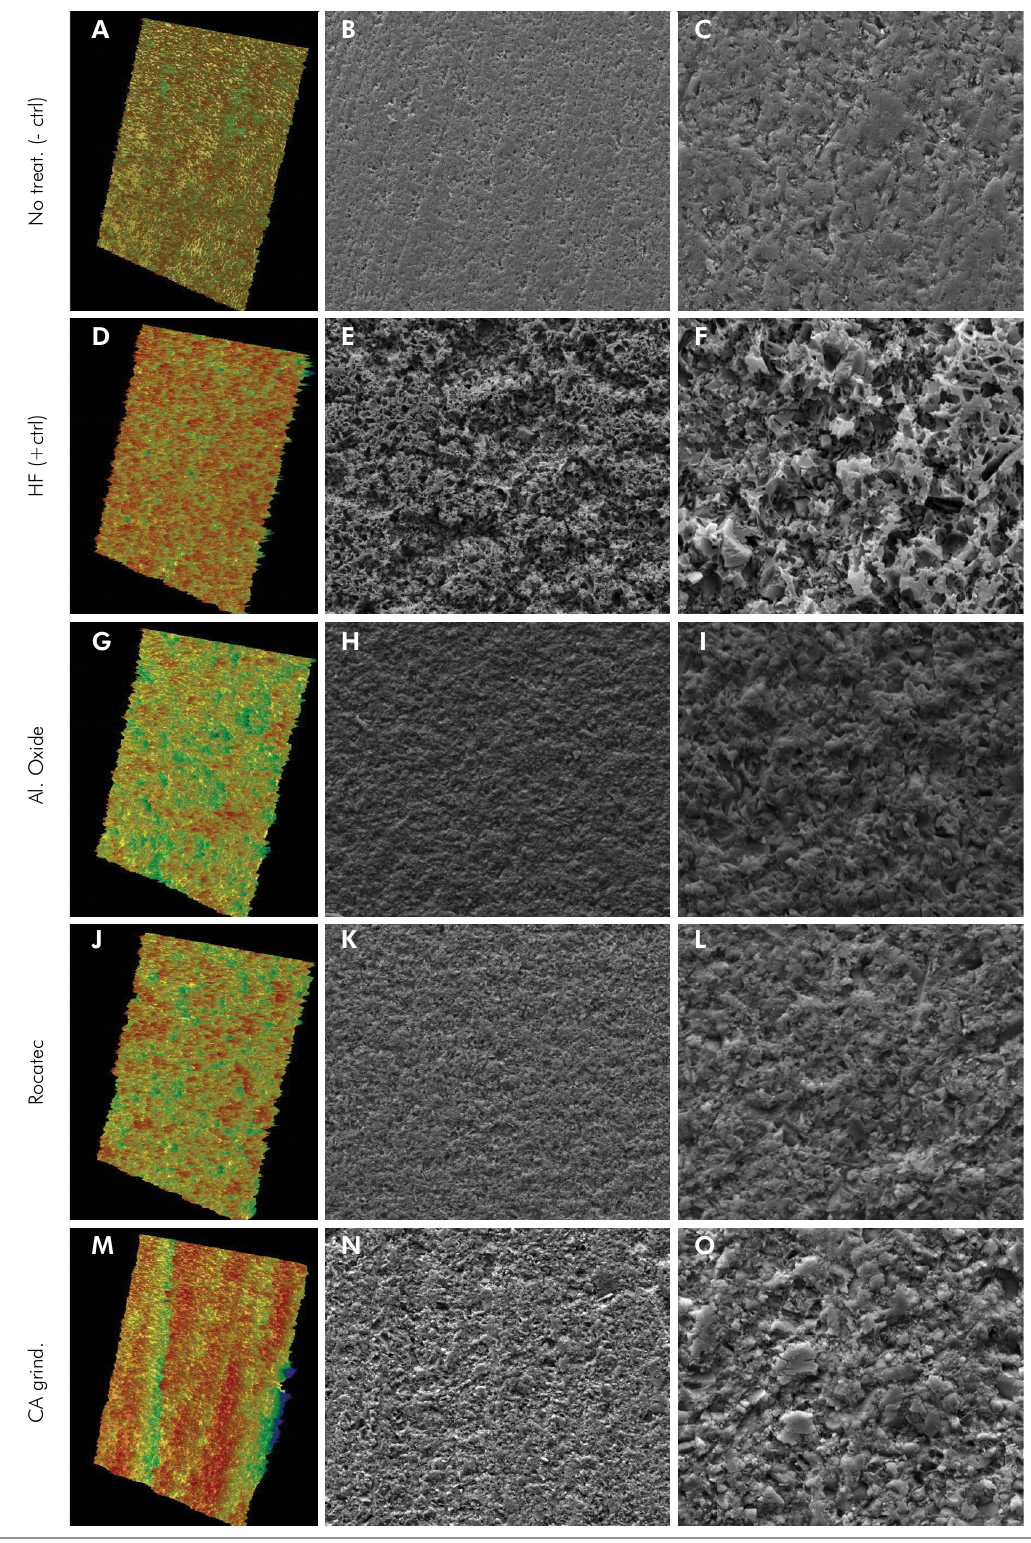
Figure 2. 3D profilometry images (A, D, G, J, M) and micrographs 1000x (B, E, H , K N), 3000x (C, F, I L, O) of the hybrid ceramic after surface treatments. The carbide ground specimen looks more irregular than others groups. The HF treated specimen shows another irregular standard surface which is related to a different type of ceramic (glass matrix) removal